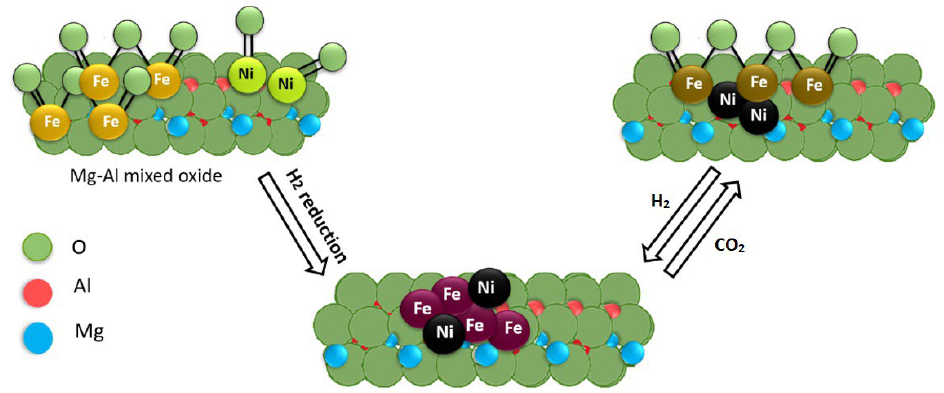
Figure 9. Schematic diagram of Fe-Ni alloy formation, during H 2 reduction, and decomposition, during CO 2 oxidation Adapted with permission from [191], copyright 2015, American Chemical So- ciety.